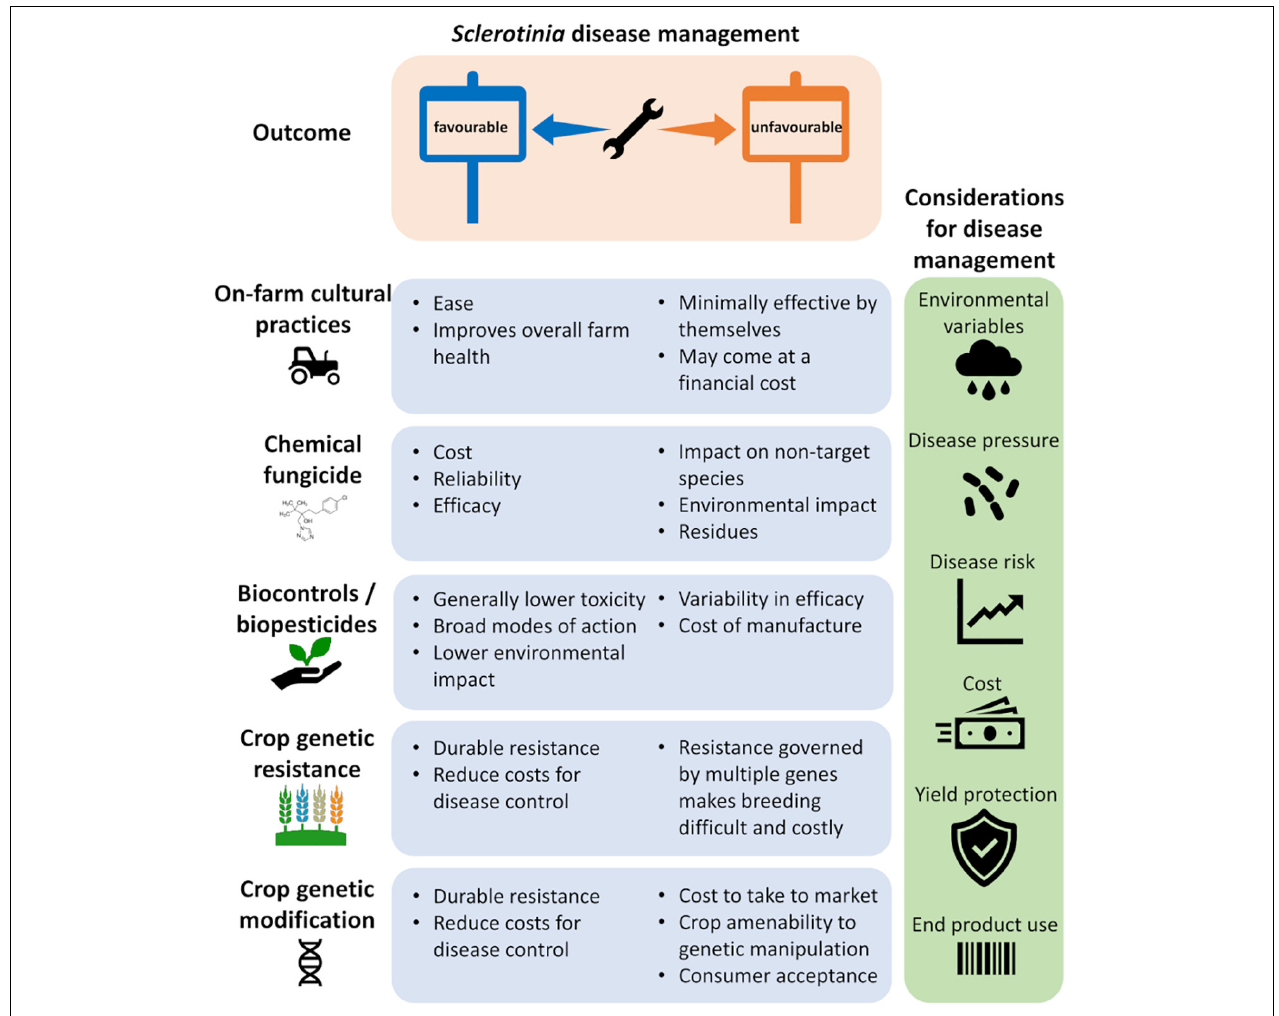
FIGURE 2 | Sclerotinia disease management. Current strategies to control Sclerotinia diseases rely on integrated disease management, each with its pros and cons (blue panels) toward the desired outcome. This may involve a combination of management strategies suited to the host crop and requires consideration and monitoring of multiple factors to guide decision on best suited disease control tools (green